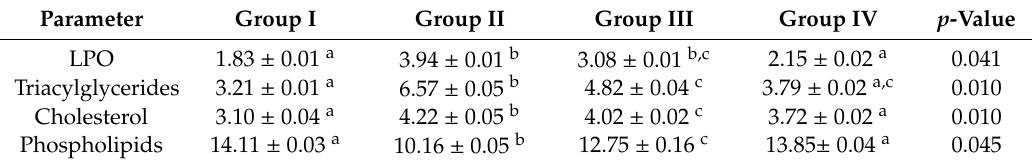
Table 3. E ff ect of EEAB on lipid peroxidation (LPO) and lipid profiles in liver tissue of rats intoxicated with CCl 4 .